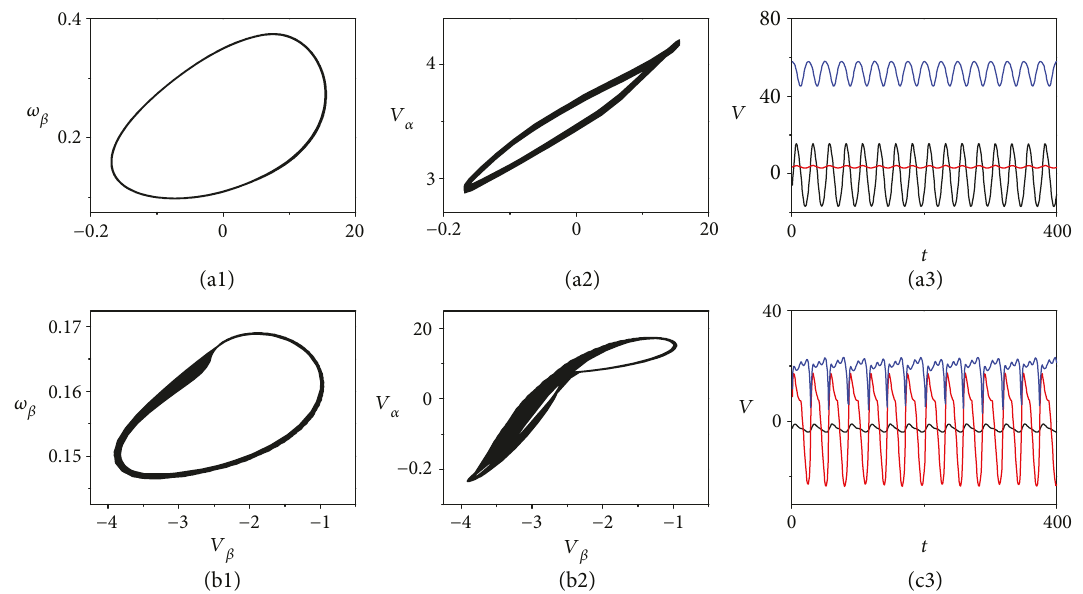
Figure 10: Numerical simulations of the two neuron system. the parameters are chosen as C = 0 5 and τ = 100 ms. (a1) The phase portrait of ( V β , ω β ), H syn = 0 1 . (a2) The phase portrait of ( V β , V α ), H syn = 0 1 . (a3) The time series of V β (black line), V α (red line), and e (blue line), H syn = 0 1 . (b1) The phase portrait of ( V β , ω β ), H syn = 0 4 . (b2) The phase portrait of ( V β , V α ), H syn = 0 4 . (b3) The time series of V β (black line), V α (red line), and e (blue line), H syn = 0 4 .